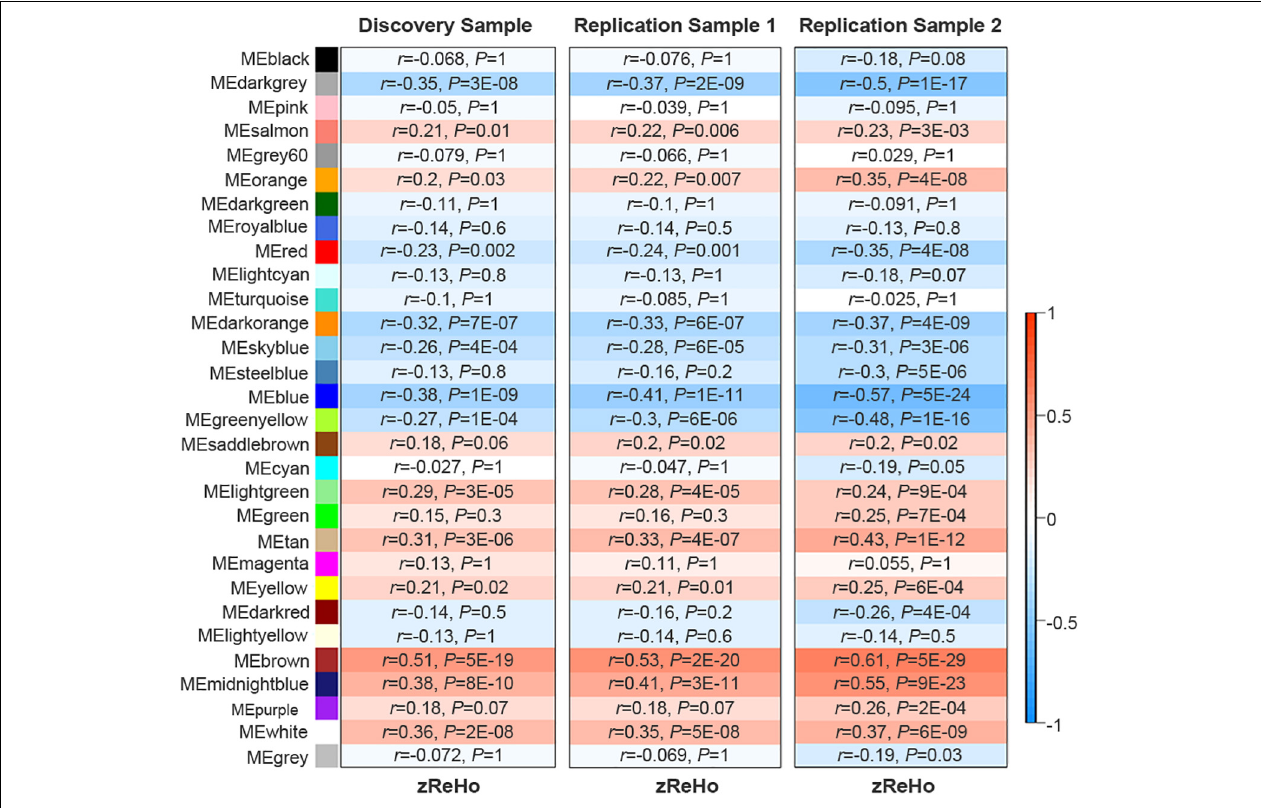
FIGURE 2 | Identification of ReHo-related gene modules. The original 30 modules in the discovery sample and the two replication samples. Color bar denotes correlation coefficients between ME and zReHo. Warm color represents positive correlations and cold color represents negative correlations with correlation coefficients and Bonferroni-corrected P values listed for each module. ME, module eigengene; zReHo, z transformed regional homogeneity.